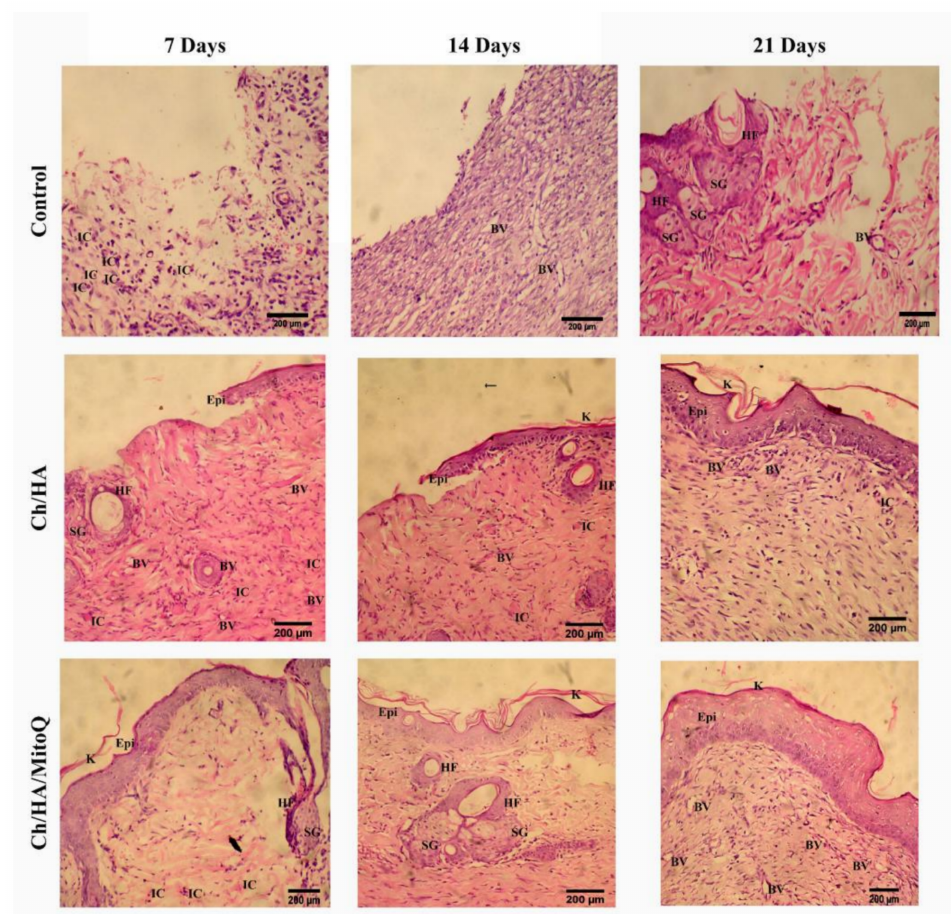
Figure 6. Histology of wounds treated with control (gauze), Ch/HA, and Ch/HA/MitoQ membranes at the 7 th , 14 th , and 21 st day after the injury. Epi: Epidermis; K: keratinous layers; IC: possible site of inflammatory cells; BV: blood vessels; HF: hair follicles; SG: sebaceous